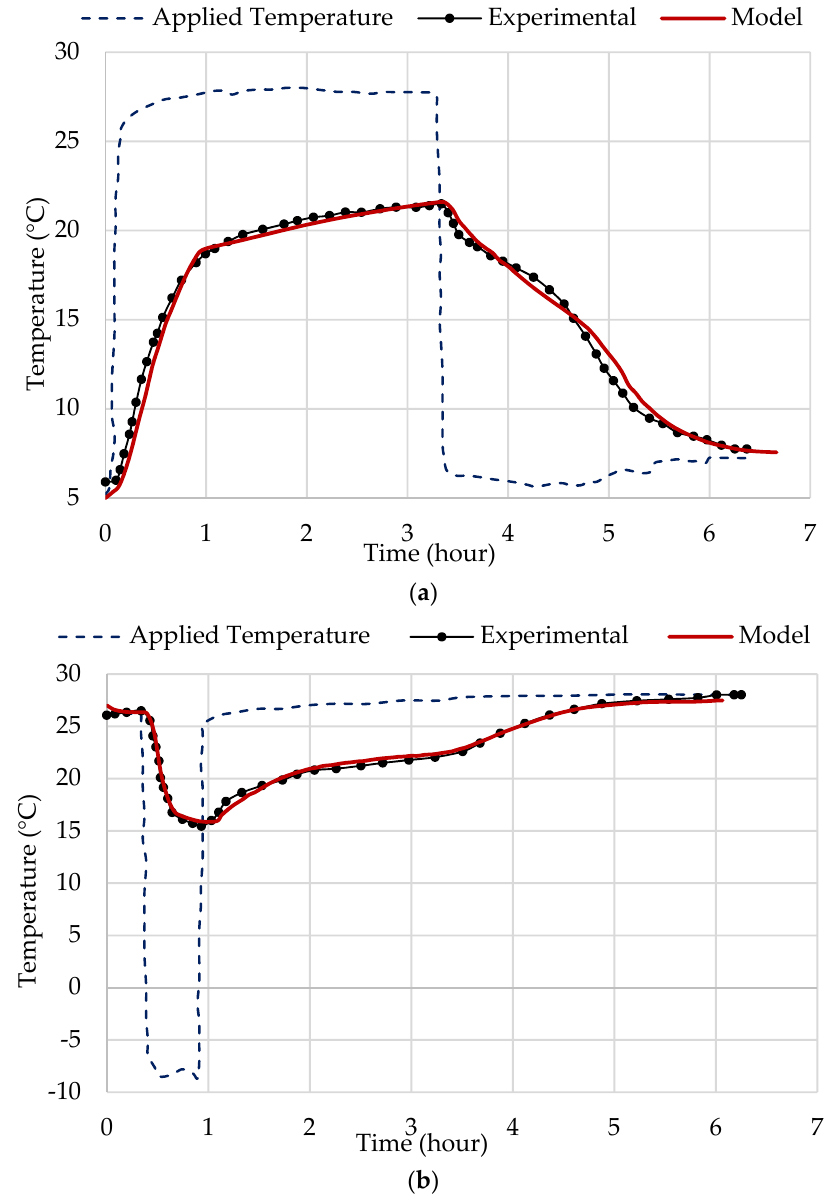
Figure 5. Validation of hysteresis model with [50]: ( a ) interrupted melting, ( b ) interrupted freez- ing.